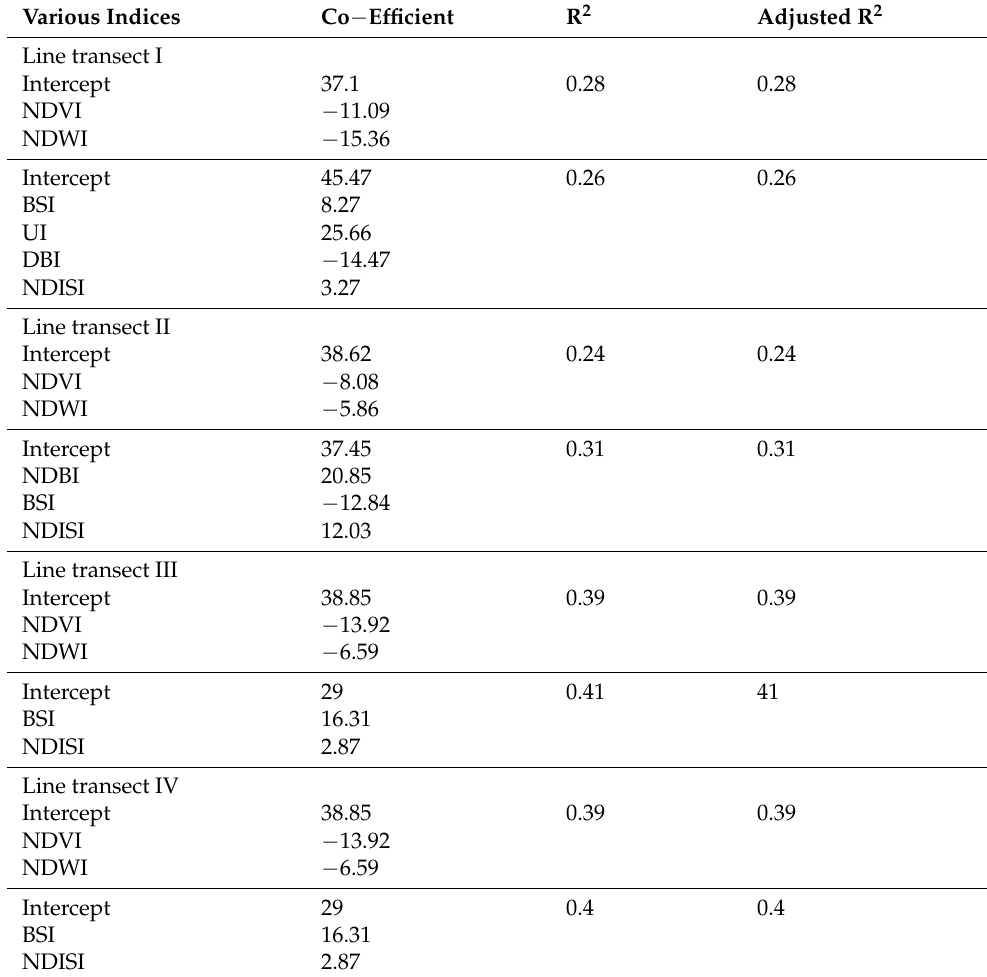
Table 6. The multiple linear regression (MLR) between LST and LULC